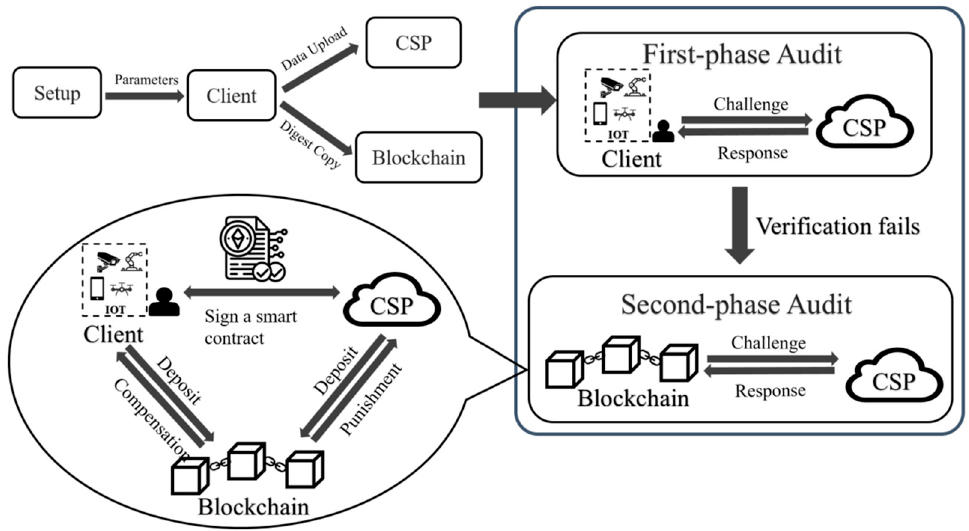
Figure 2. Architecture of our two-phase data auditing scheme.